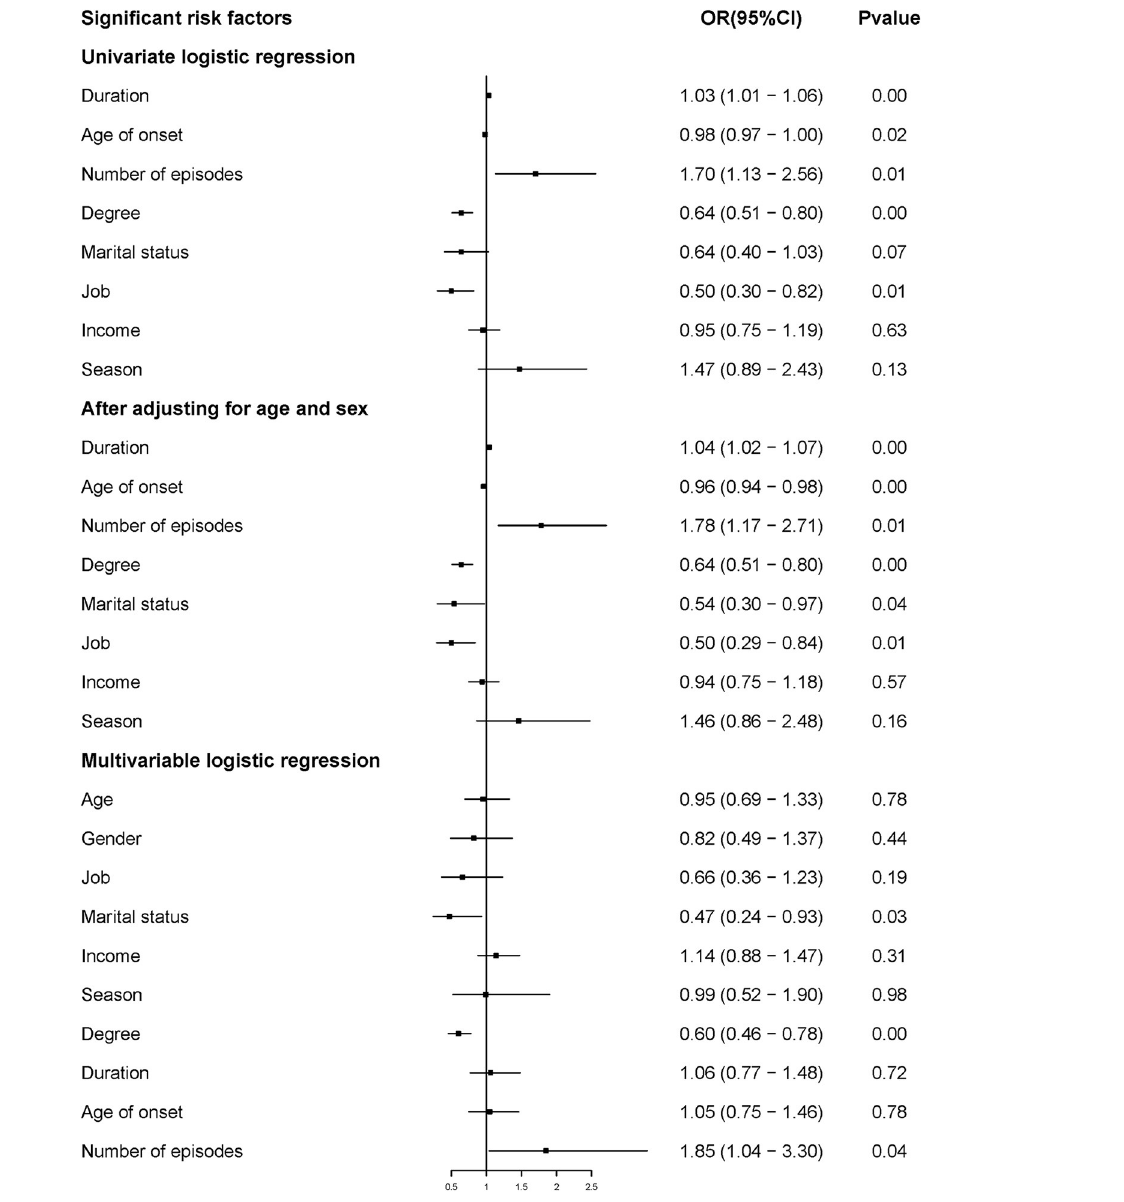
FIGURE 1 | Risk prediction of demographic information and clinical characteristics for the risk of